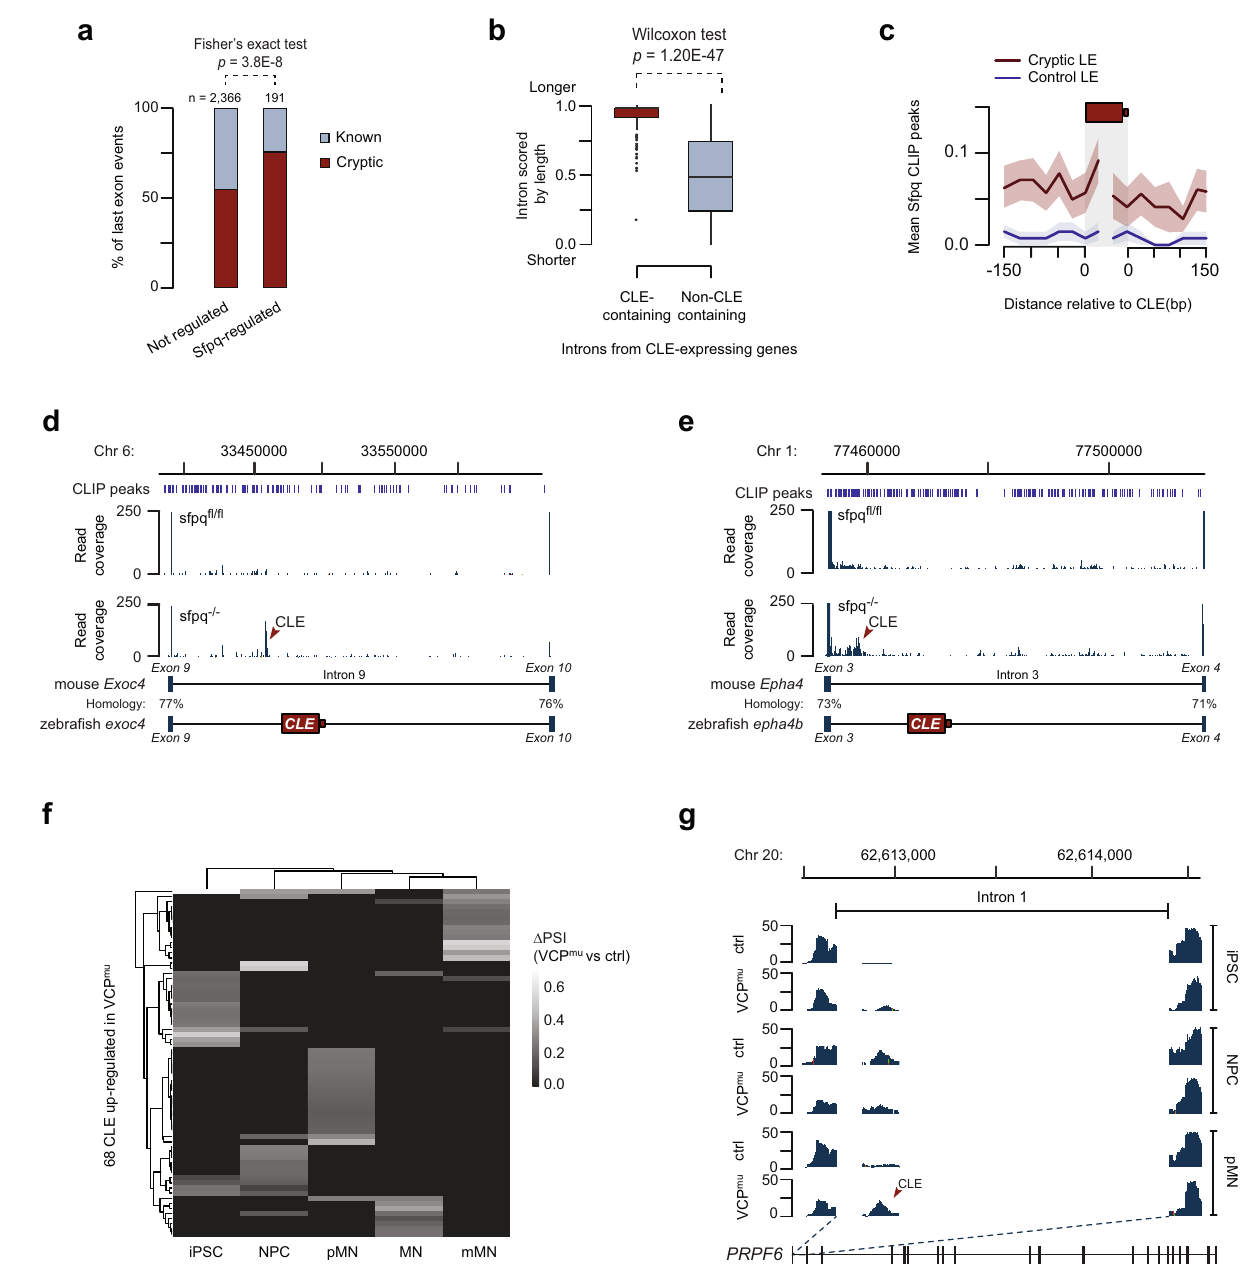
Fig. 6 The CLE-repressing function of SFPQ is conserved in mouse and human. a Bar plot of the proportion of unannotated (cryptic) last exons from mouse cortical neurons grouped based on their regulation by Sfpq. Two-sided Fisher ’ s exact test was performed. b Introns from mouse CLE-expressing genes were scored by their relative length and the distribution of these scores were plotted. The box bounds represent the fi rst and third quartiles and the black lines at the middle of the boxes show the medians. Top and/or bottom whiskers represent 1.5x of the range between the third and the fi rst quartiles (interquartile range). Circles represent outliers. Two-sided Wilcoxon rank-sum test was performed. c Metaplot of the mean number of Sfpq CLIP peaks (±SEM) in region surrounding cryptic last exons or constitutive last exons of the same gene (control). d , e CLIP-seq peak distribution (top) and RNA-seq coverage plots (mid) from representative CLE-containing introns. The Y -axis scale of the read coverage plots is optimized for CLE/intronic reads. Sequence homology of fl anking exons from orthologous CLE-containing genes is compared and the relative position of zebra fi sh CLEs is shown at the bottom. f Heatmap illustrating increased inclusion ( Δ PSI) of 68 CLEs upregulated in ALS-mutant background at different stages of neuronal differentiation. Δ PSI values of non-signi fi cant events are set to 0. Induced pluripotent stem cells (iPSC); neural precursors (NPC); “ patterned ” precursor motor neurons (ventral spinal cord; pMN); post-mitotic but electrophysiologically immature motor neurons (MN); electrophysiologically mature MNs (mMN). g Representative RNA-seq coverage plots from ALS-derived iPSC dataset of CLEs upregulated in VCP mu